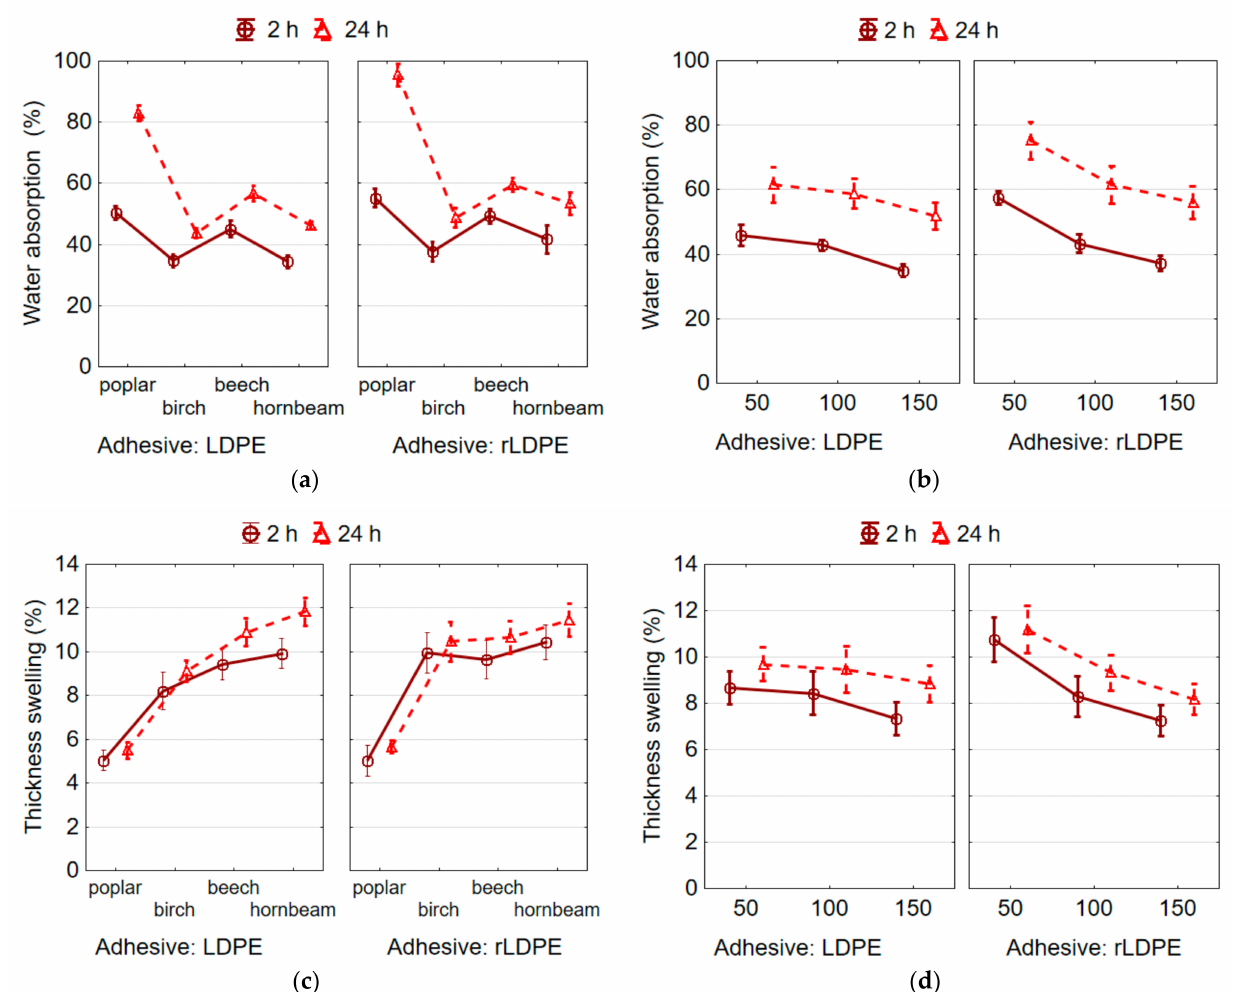
Figure 6. Mean plots of WA ( a , b ) and TS ( c , d ) of plywood samples depending on wood species ( a , c ) and thickness of film ( b , d